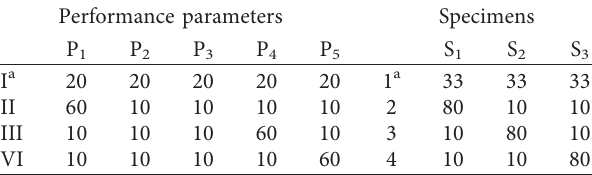
Table 7: Different sets of weighting factors (%).